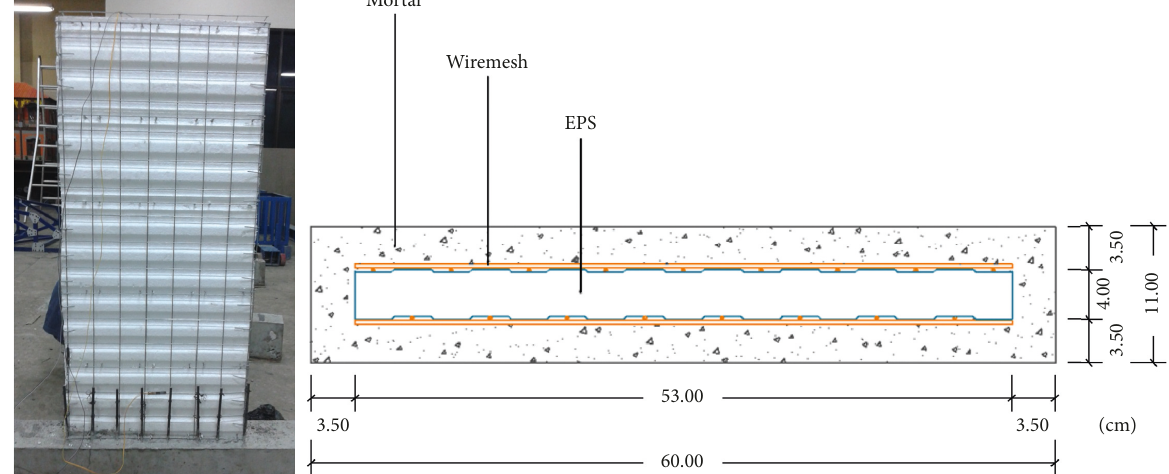
Figure 2: Basic properties of wall specimens.